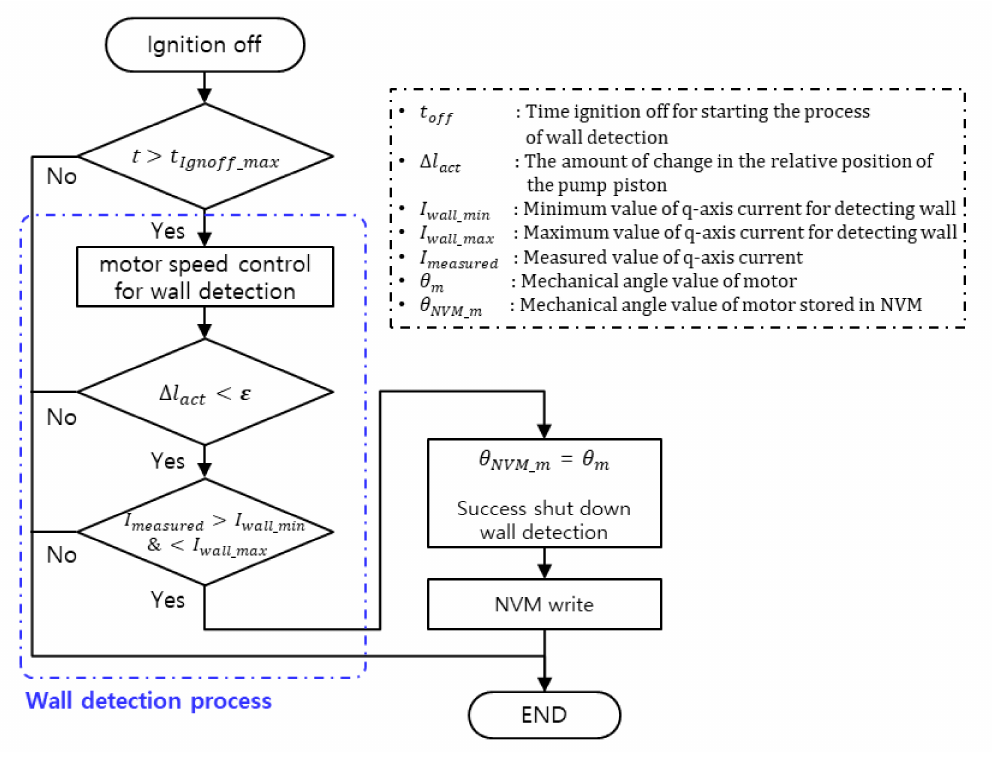
Figure 4. Flowchart of the proposed wall detection with the EHB system with the ignition